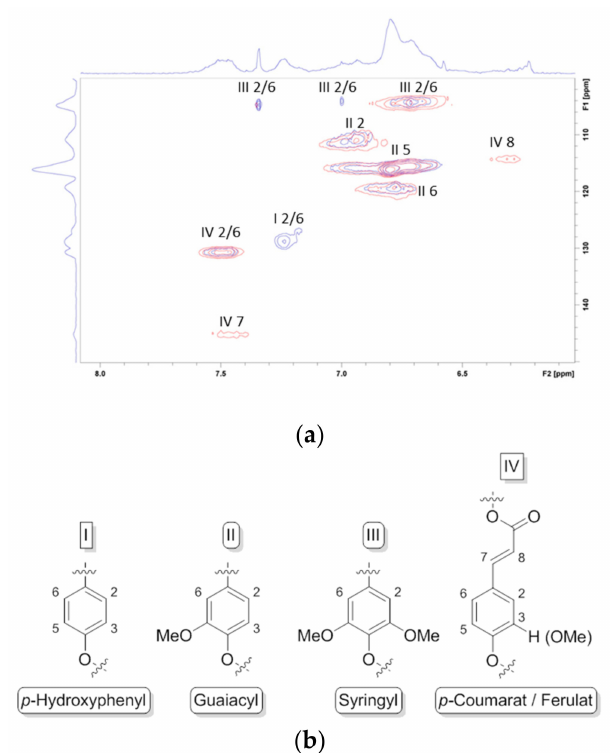
Figure 5. ( a ) HSQC NMR spectrum, aromatic region (dC/dH 100–150/6.0–8.0) of lignin samples obtained via Organosolv process from Miscanthus X giganteus . Comparison of leaf lignin (blue) and stem lignin (red) and ( b ) corresponding assigned lignin fragments. Copyright Springer